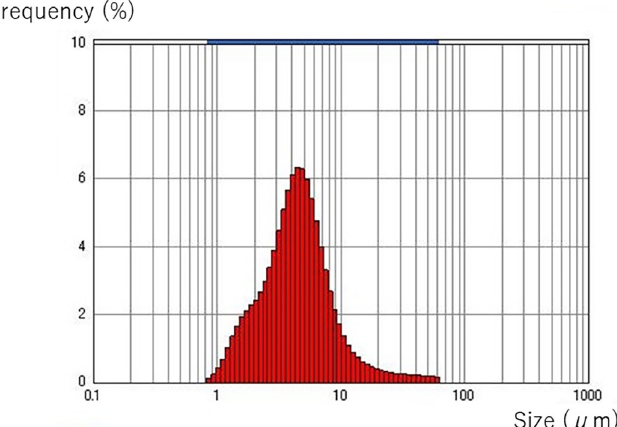
Fig 2. MFG size distribution (thawed milk prior to fortification). The particle size distribution after the freeze-thaw process prior to any fortification is shown.